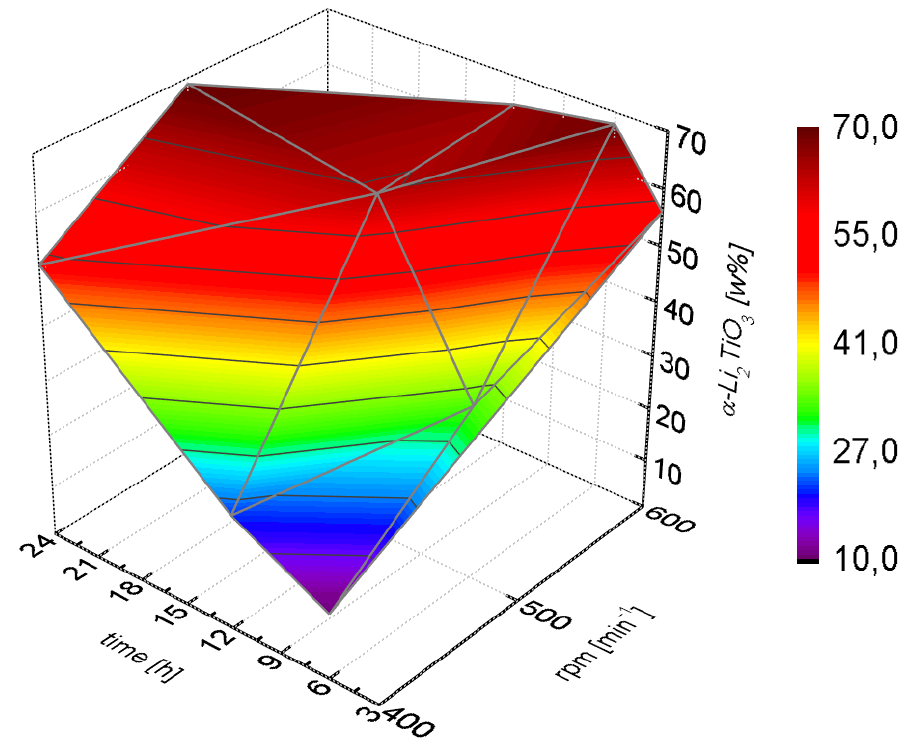
Figure 3. Weight portions (from Rietveld refinement) of α -Li 2 TiO 3 after milling of LiOH and rutile in WC tools with different parameters.